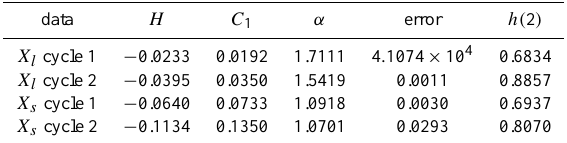
flected by the K(q) and h(q) curves based on raw